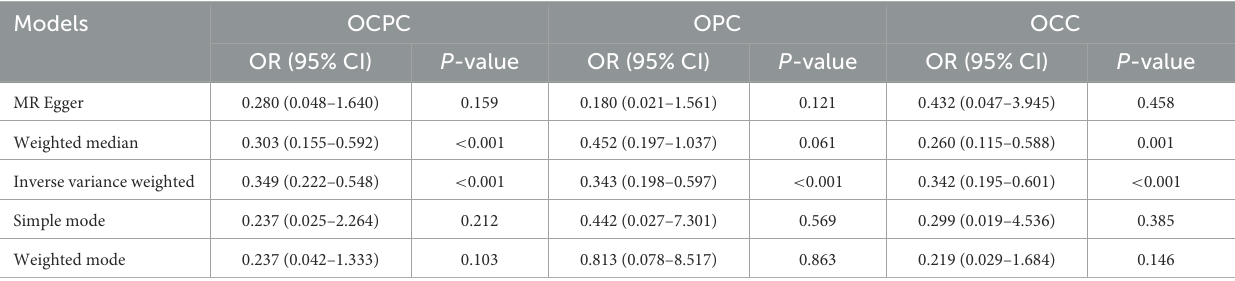
TABLE 1 MR estimates of the causal effect of EA on OCPC, OCC, and OPC.